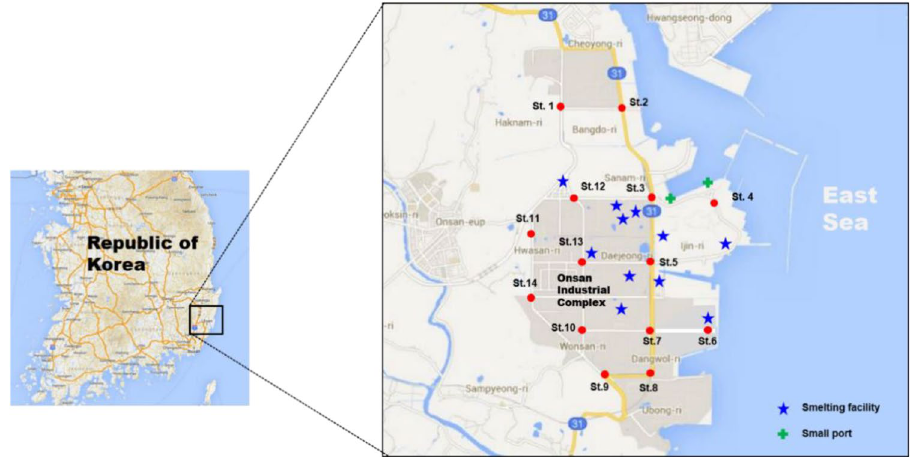
Figure 1. Locations of sampling sites for road deposited sediments from Onsan industrial complex including the smelter of Korea. Figure created using Microsoft Office PowerPoint 2016 based on Google Maps (available at https:// www. google. com/